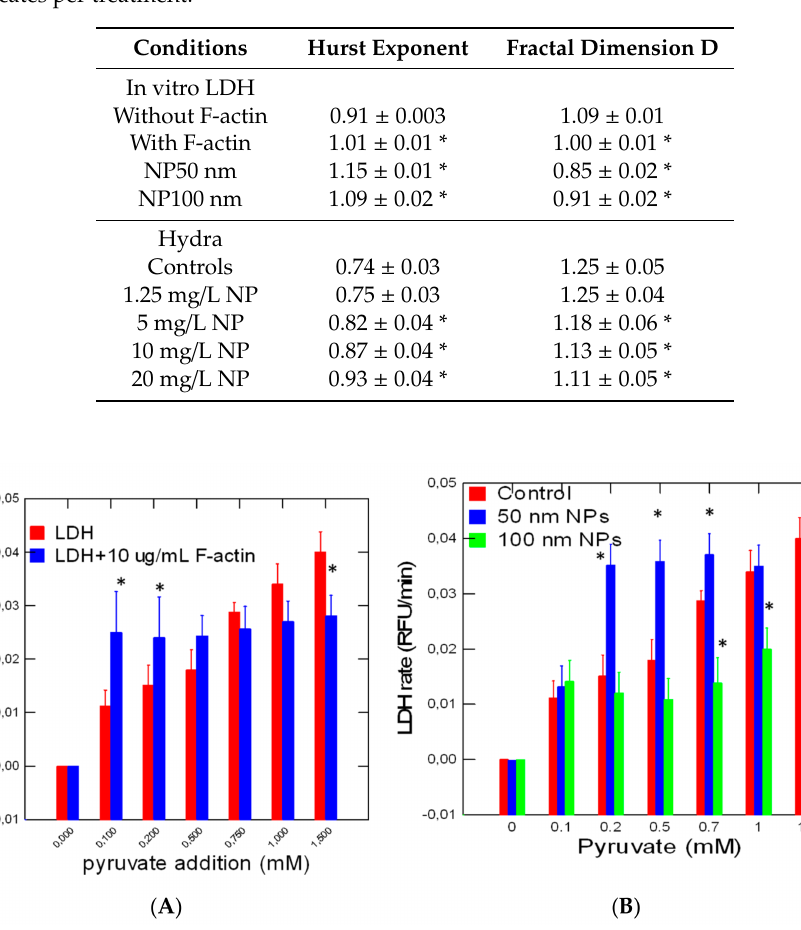
Figure 1. The fractal kinetic behavior of LDH in the presence of F-actin and 50 nm nanoparticles (NPs). LDH activity was determined alone and in the presence of F-actin ( A ) and 50 / 100 nm diameter NP ( B ). The data represent the mean with standard error for N = 3 replicates per treatment. The treatments were all significant from controls. The star symbol indicates di ff erence between the crowding agents (F-actin, 50 and 100 nm NPs) and LDH alone. * p < 0.05.